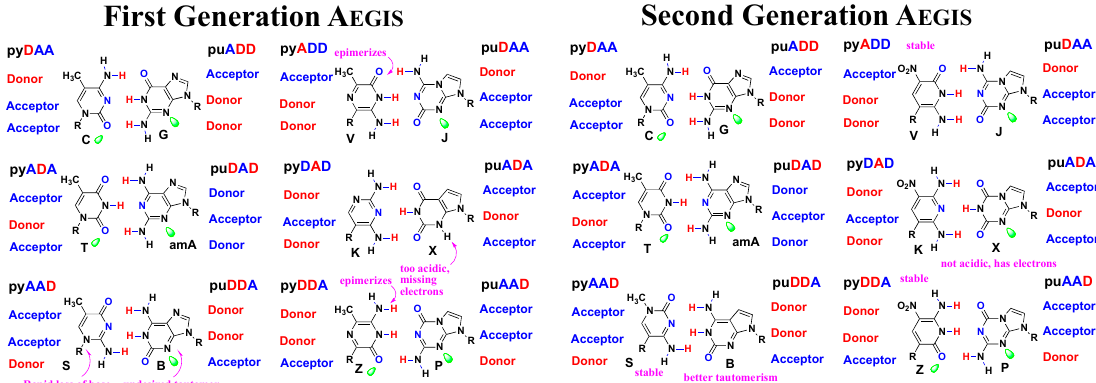
Figure 1. Examples of artificially expanded genetic information system (AEGIS) xNA building blocks in their “first generation” forms (left) and their “second generation” forms (right). AEGIS exploits the two rules that guide standard Watson–Crick nucleobase pairing: (a) size (large purines with small pyrimidines) and (b) hydrogen bonding (hydrogen bond acceptors A, with hydrogen bond donors D). Rearranging A and D groups gives an artificially expanded genetic information system (AEGIS) with up to 12 nucleotides forming six orthogonal pairs, with a functionality not present in standard DNA. AEGIS Z, for example, carries a nitro group (enhance the intrinsic binding potential of AEGIS libraries, and allowing the nucleobase to act as a general acid-base).